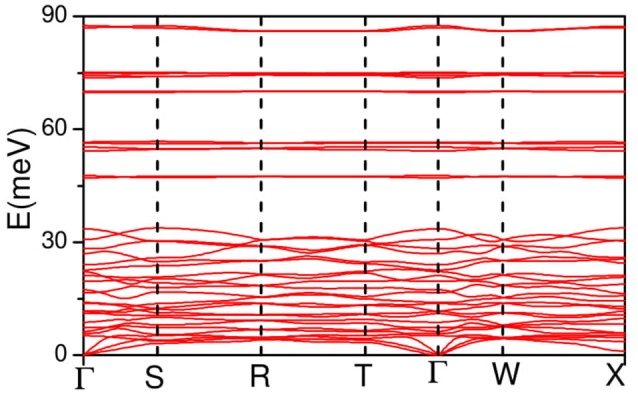
The calculated phonon dispersion curves along the high symmetry directions in the Brillouin zone AgC4N3. The Bradley-Cracknell notation is used for the high-symmetry points; Γ(0, 0, 0), S(1/2, 0, 0), R(0, 1/2, 0), T(1/2 0 0), W(1/4, 1/4, 1/4), and X(1/2, −1/2, 1/2).